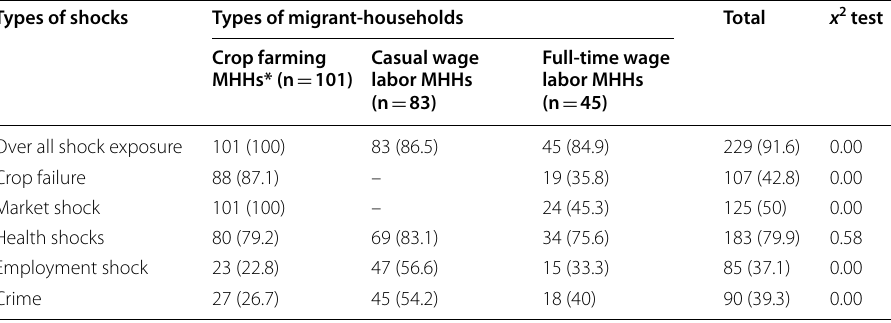
Figures in parenthesis are percentages * MHHs